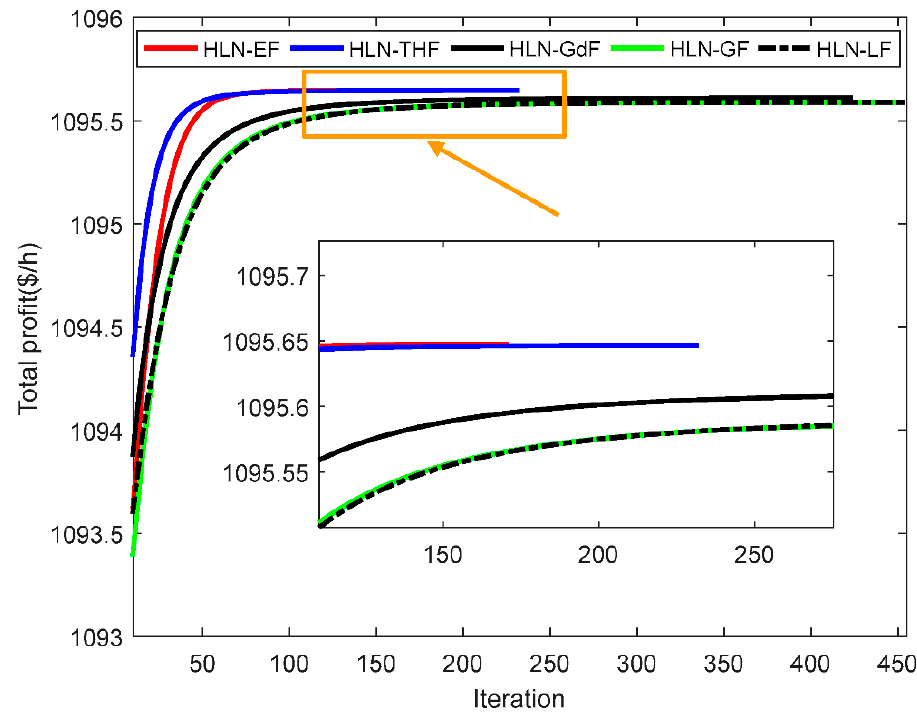
Figure 7. Total profit for the first system with the second model of payment. All of the data of the system and optimal solutions obtained by the HLN-EF for the system are shown in Tables A1 and A2 of Appendix